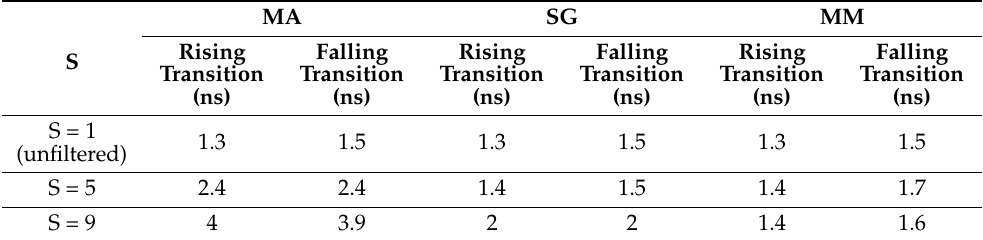
Figure 5. Response of the 4-bit Golay decoded signal to multiple filters: ( a ) with MA, S = 5, and 9; ( b ) with SG, S = 5, and 9; ( c ) with MM, S = 5, and 9. Table 1. Transition duration properties of 4-bit Golay signal associated with